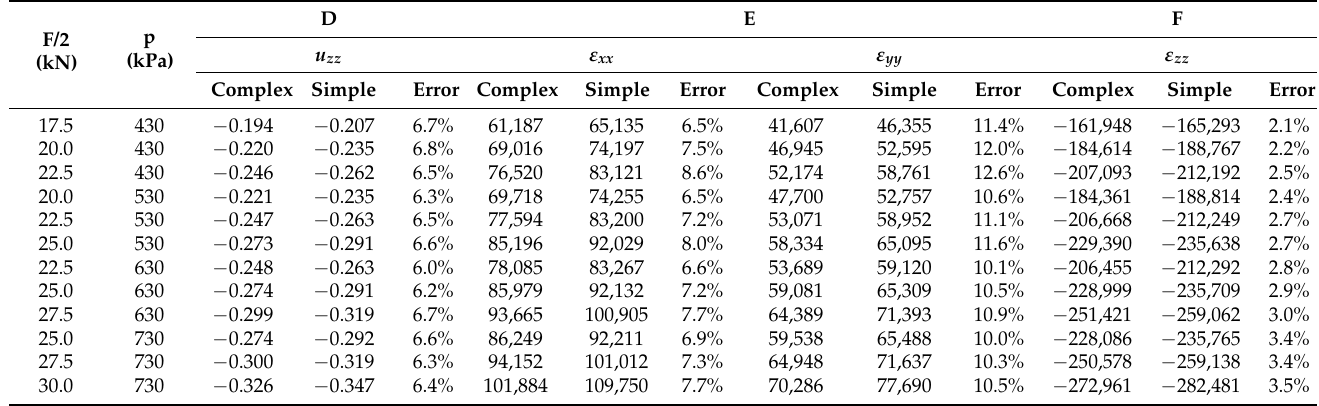
Table 10. Stresses and strains in the flexible road pavement structure straight below the